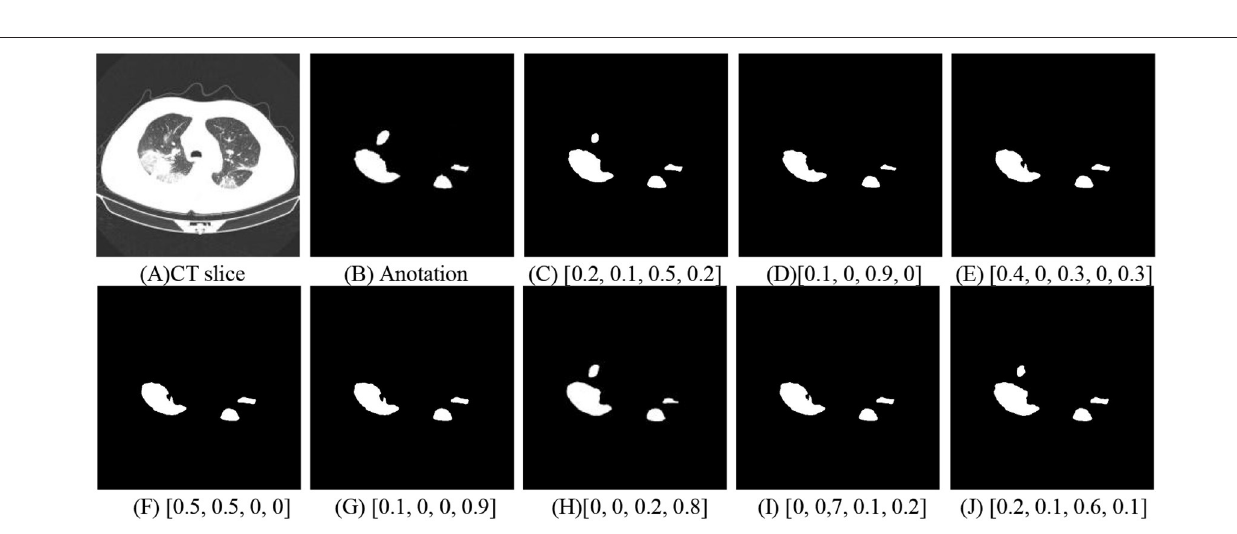
FIGURE 10 | COVID-19 lesion segmentation with different weighting parameters. (A) CT slice. (B) Anotation. (C) [0.2, 0.1, 0.5, 0.2]. (D) [0.1, 0, 0.9, 0]. (E) [0.4, 0, 0.3, 0, 0.3]. (F) [0.5, 0.5, 0, 0]. (G) [0.1, 0, 0, 0.9]. (H) [0, 0, 0.2, 0.8]. (I) [0, 0.7, 0.1, 0.2]. (J) [0.2, 0.1, 0.6,